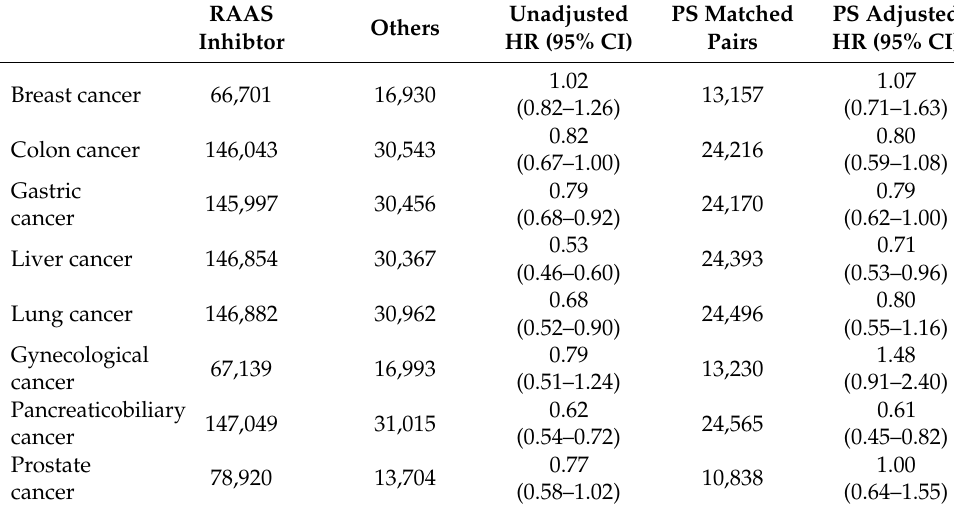
Table 2. Hazard ratio of each cancer in the overall and propensity score-matched cohort. RAAS Inhibtor